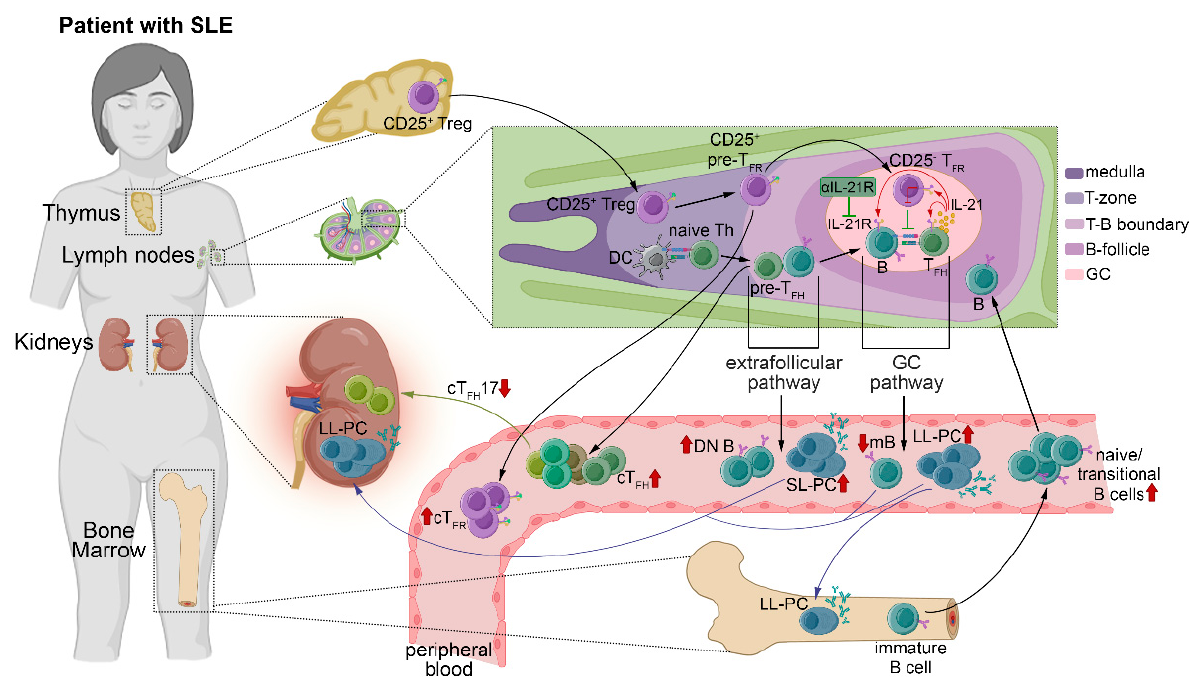
Figure 5. Summarizing the outcome of T FR /T FH cell imbalance and altered B cell differentiation in SLE. Incomplete induction of self-tolerance and B cell hyperactivity induced by disturbed immune regulation are the hallmark of lupus pathogenesis. The breakdown of early B cell tolerance leads to consequential enrichment of the ratio of transitional B cells and naive/mature–naive B cells in the circulation. The microenvironment of GCs gives place to peripheral tolerance, where T FR cells and T FH cells collaborate to regulate the multistage differentiation of B cells. T FH cells produce IL-21, which facilitates the GC reaction by promoting T FH and B cell differentiation, while inhibiting T FR function. The imbalance of T FR cell and T FH cell homeostasis in lymph nodes culminates in an increased number of activated cT FH and cT FR cells at the periphery, along with characteristic changes in the distribution of B cell subpopulations. We hypothesize that cT FH 17 cells may traffic to the site of inflammation, where they collaborate with the accumulated antibody-secreting cells and memory B cells within kidney tissues, which contributes to the progression of the disease. DC, dendritic cell; DN B, double negative B cell; GC, germinal center; IL-21, interleukin-21; IL-21R, interleukin-21 receptor; LL-PC, long-lived plasma cell; mB, memory B cell; SL-PC, short-lived plasma cell; SLE, systemic lupus erythematosus; Treg, regulatory T cell; T FR , follicular T regulatory cell; T FH , follicular T helper cells. [Some icons were inspired by Biorender.com accessed on 16 August